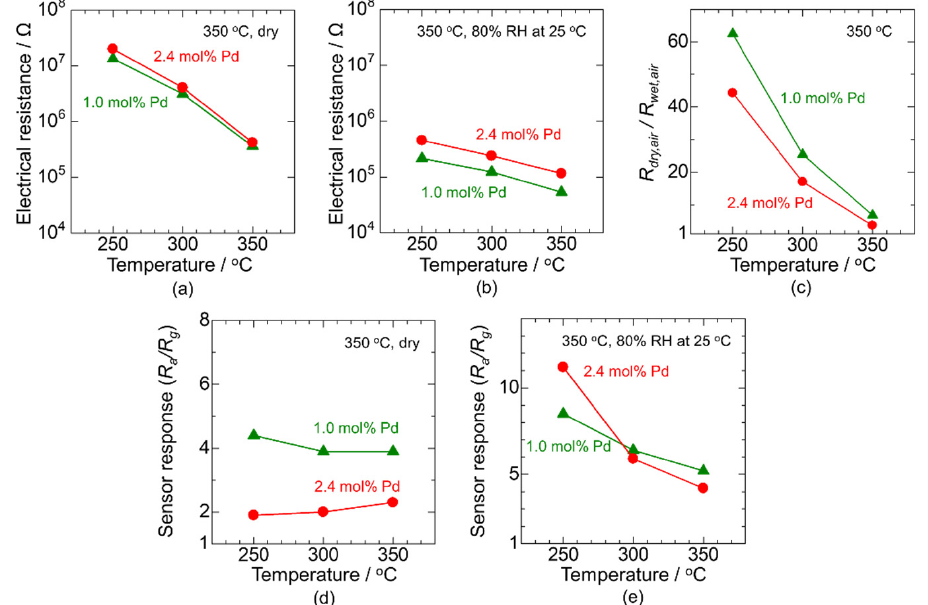
Figure 8. Temperature dependence of the electrical resistance in ( a ) dry air and ( b ) wet air, and ( c ) ratio of the electrical resistance in these atmospheres, and temperature dependence of the sensor response to 200 ppm CO in ( d ) dry and ( e ) wet atmospheres. The demonstration was carried out using CP-1.0Pd/SnO 2 and CP-2.4Pd/SnO 2 . The humidity of the wet atmosphere was approximately 80% RH at 25 °C.